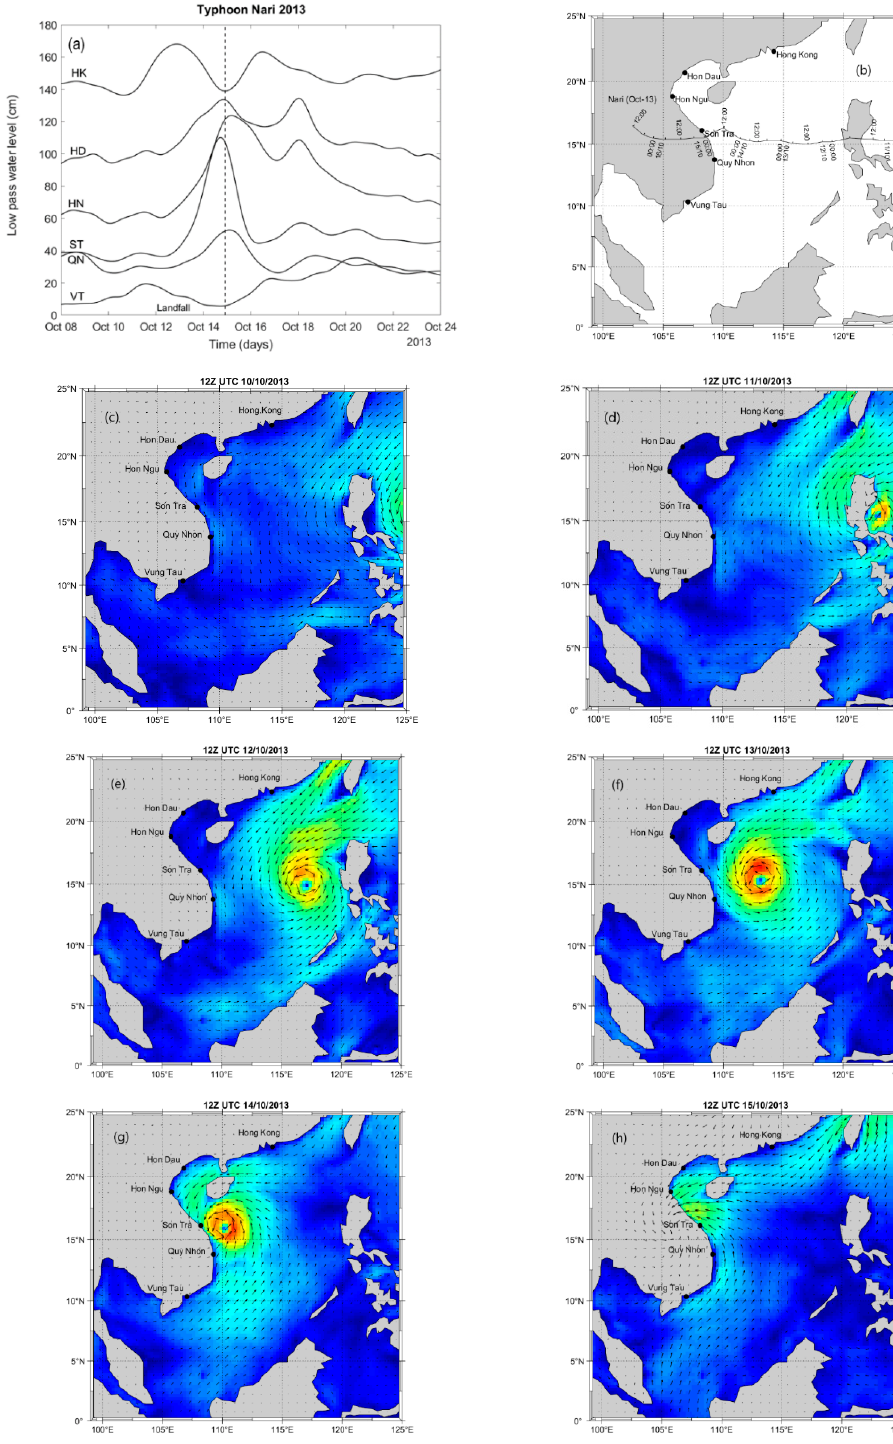
Figure 13. ( a ) Time series of observed, residual and low-pass filtered water levels during Typhoon Nari (8–24 October 2013) at all stations; ( b ) the track of Typhoon Nari and ( c – h )—wind fields at 12Z UTC from 10 to 15 October 2013. Key: HK: Hong Kong; HD: Hon Dau; HN: Hon Ngu; ST: Son Tra, QN: Quy Nhon; VT: Vung Tau. The wind speed colour scale is given in Figure 9.